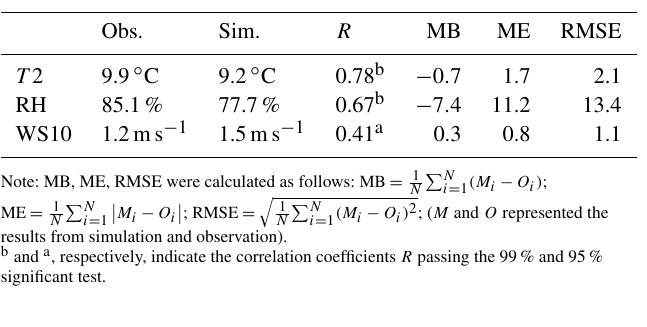
Table 4. Statistical metrics of comparisons between simulated and observed surface PM 2 . 5 concentrations in two levels of light and heavy PM 2 . 5 pollution during 2–7 January